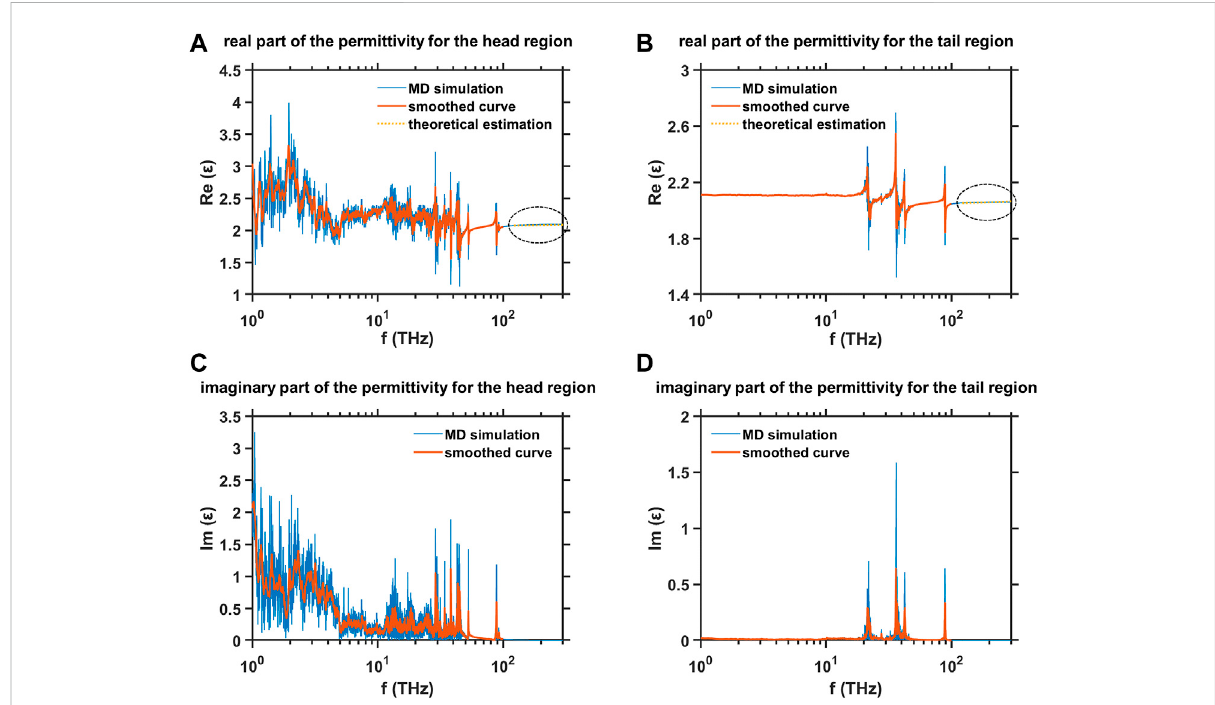
MDsimulationresultsofthedielectricspectrainthefrequencyrangefromterahertztomid-infraredfortworegionsofhydrophilicheadandthe hydrophobic tail in the equilibrated DMPC monolayer (A) Real part of the permittivity for the head region, (B) real part of the permittivity for the tail region, (C) imaginary part of the permittivity for the head region, and (D) imaginary part of the permittivity for the tail